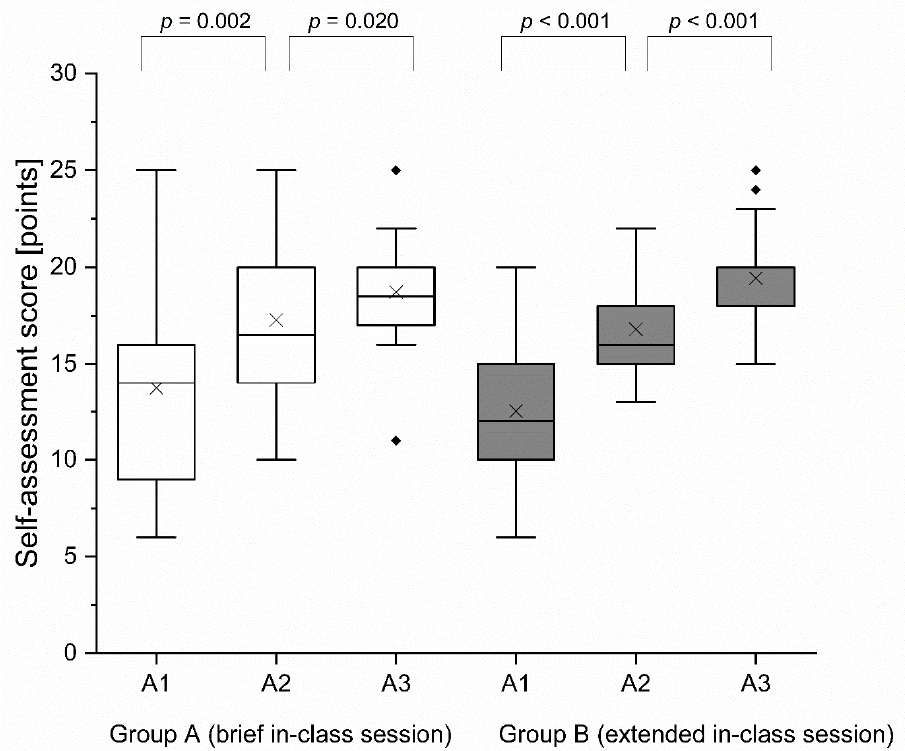
Figure 3. Self-assessment score per group. Black cross mark ( × ) = mean; horizontal line = median; black diamond ( ♦ ) = outlier; A1 = assessment 1; A2 = assessment 2; A3 = assessment 3.